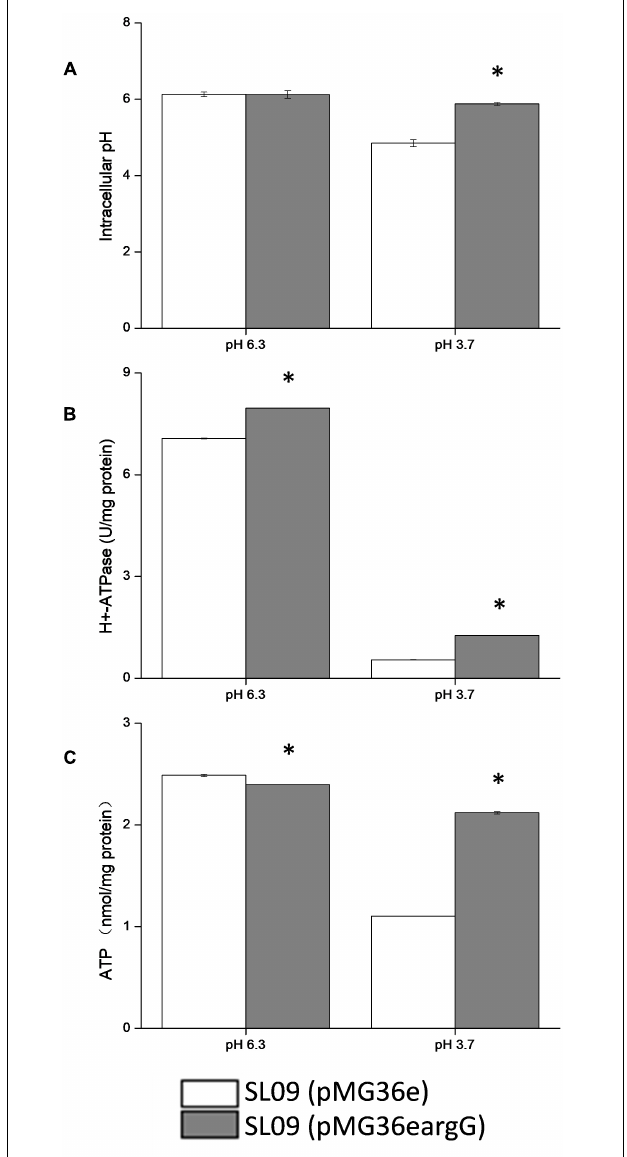
FIGURE 7 | Effect of argG gene heterologous expression on intracellular pH (A) , H + -ATPase activity (B) , and intracellular ATP level (C) . ∗ Difference significant at 95% confidence